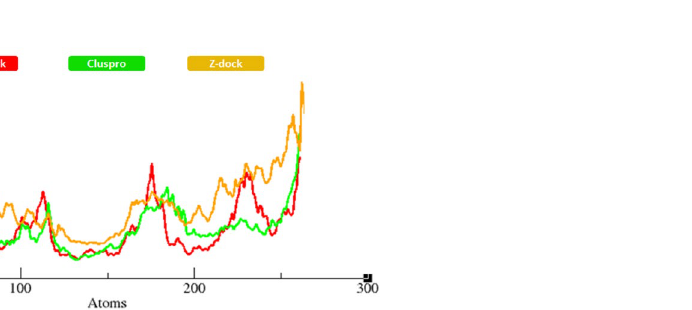
Figure 9. RMSF graphs showing fluctuations of protein backbone residues during 50,000 ps simulation.